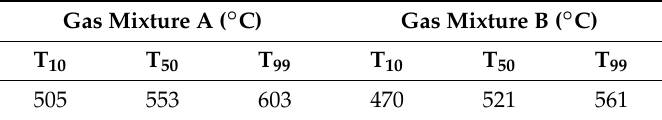
Table 3. Temperatures of 10%, 50%, and 99% conversion of N 2 O ( T 10 , T 50 , and T 99 ) over the Cu–Zn/ γ –Al 2 O 3